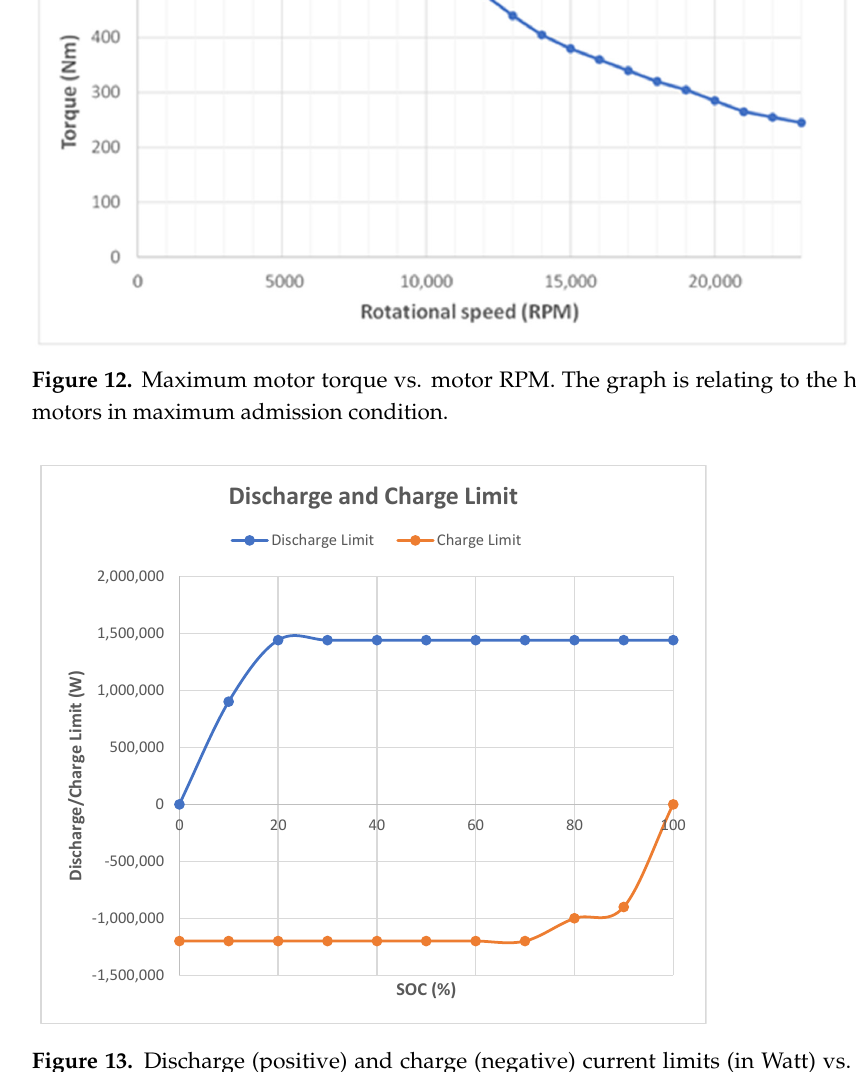
Figure 14. OCV (Open Circuit Voltage) vs. the SOC of the battery pack. Table 4. Internal resistance (expressed in Ohm) of each cell in function to the SOC (from 0 to 1, first row of the table) and to the temperature in Kelvin (from 243.1 K to 313.1 K, first column of the table).